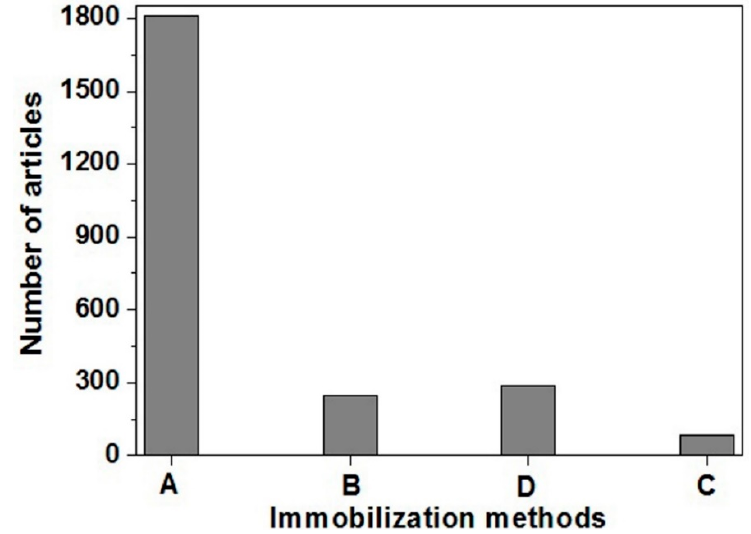
Figure 3. Research articles published in the last 10 years with the following keyword search: (A) “biosensor using adsorption,” (B) “biosensor using encapsulation,” (C) “biosensor using crosslinking” and (D) “biosensor using covalent bonding”, either in the title or in the abstract [26].